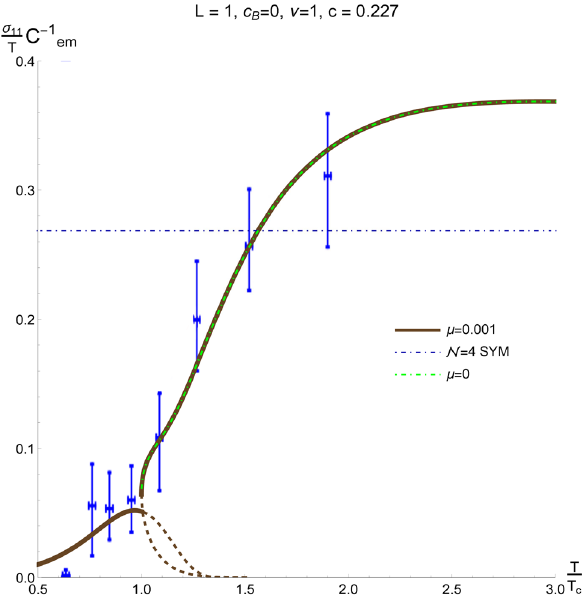
Fig. 3 The dependence of ratio σ 11 / T on the temperature T normal- ized by the critical value T c = 0 . 163 corresponding to the Hawking– Page phase transition is presented. The solid brown line corresponds to the stable phase with a small non-zero chemical potential μ = 0 . 001 while the green dash-dotted line represents the μ = 0 case. The blue dash-dotted line is N = 4 SYM conductivity σ/ T = e 2 N 2 c / 16 π . Blue dots correspond to lattice calculations from [50] for N c = N f = 3